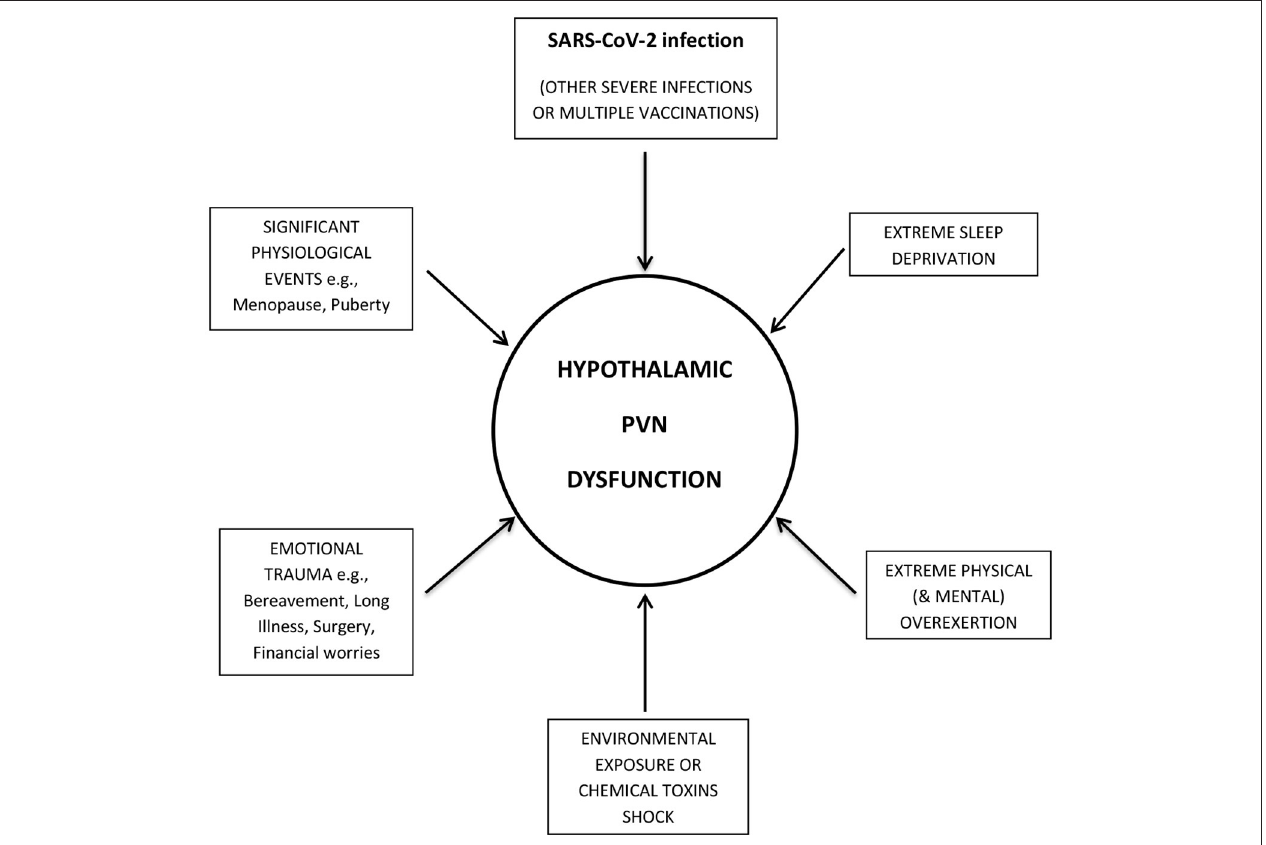
FIGURE 1 | SARS-CoV-2 infection, in common with other stressors , targets the Hypothalamic Paraventricular Nucleus (PVN). SARS-CoV-2 infection produces an inflammatory response, which, in common with other physiological stressors (and potential triggers of ME/CFS), targets the hypothalamic paraventricular nucleus (PVN). If a certain stress - threshold , intrinsic to genetically susceptible people, is exceeded, the hypothalamic PVN switches into an ongoing dysfunctional mode, causing Post-COVID-19 Fatigue